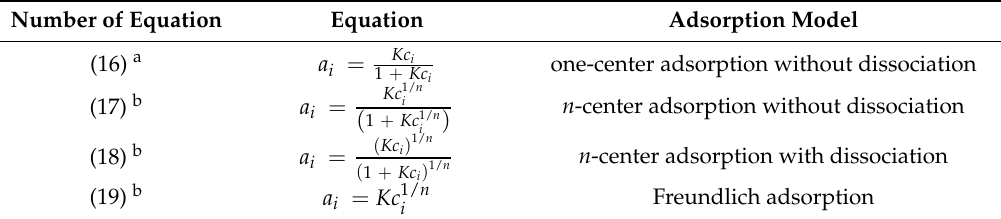
Table 4. The proposed adsorption models and forms of Langmuir and Freundlich